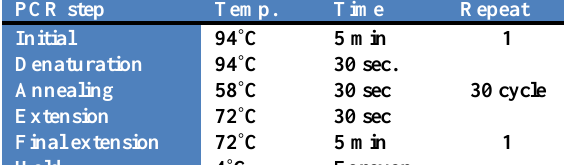
Table, 5: Nested- PCR thermocycler system.